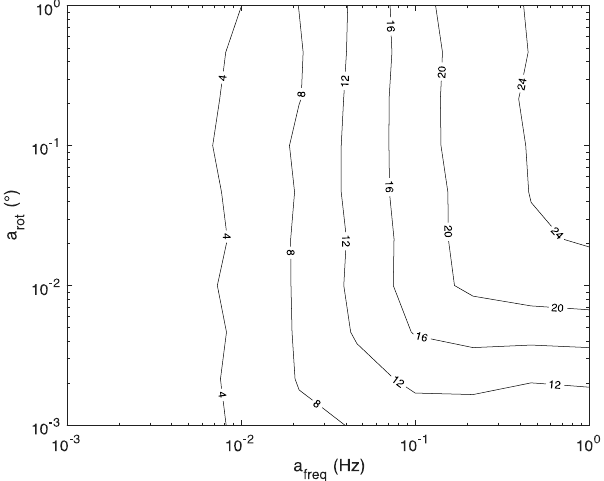
Figure 3. Example of a confusion matrix for a freq = 0.01 Hz and a rot = 0.1°. Dam and Undam refer to the damaged and undamaged structure, respectively. The percentages in the grey cells can be interpreted as “precision”, “specificity”, and so forth (check [28] for each single term).